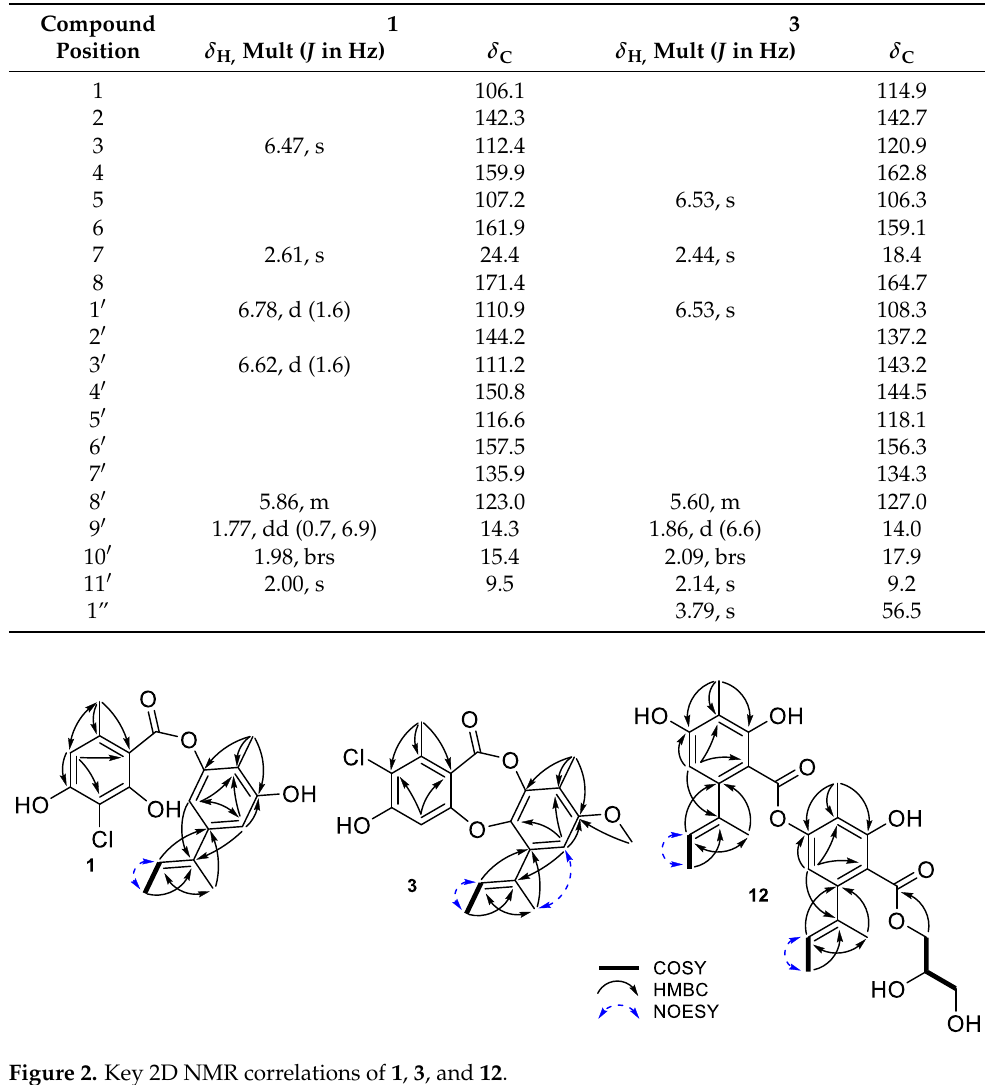
Table 1. 1 H and 13 C NMR data of 1 and 3 in CD 3 OD (600 MHz for 1 H and 150 MHz for 13 C).